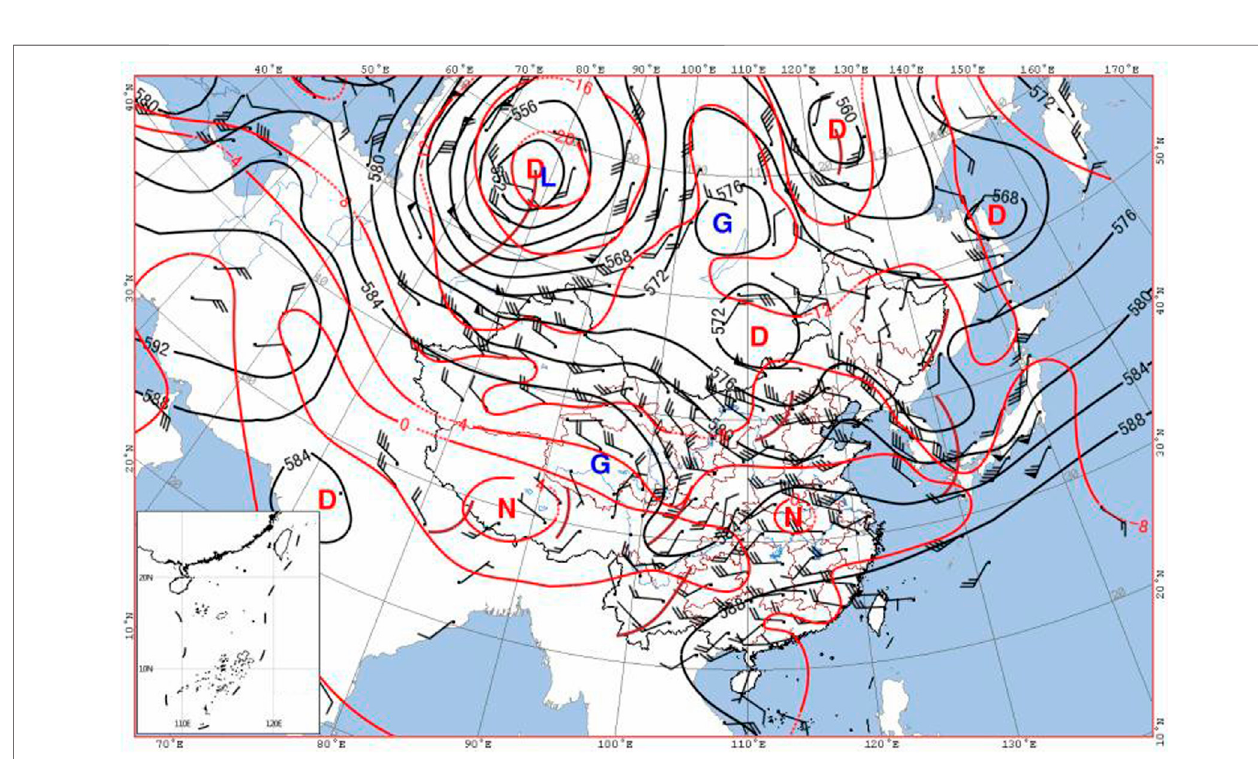
FIGURE 3 | Wind fi eld, height fi eld (black isolines) and temperature fi eld (red isolines) at 500 hPa at 20:00 on July 9, 2010. (G. D, N and L are high pressure center, low pressure center, warm center and cold center in turn)